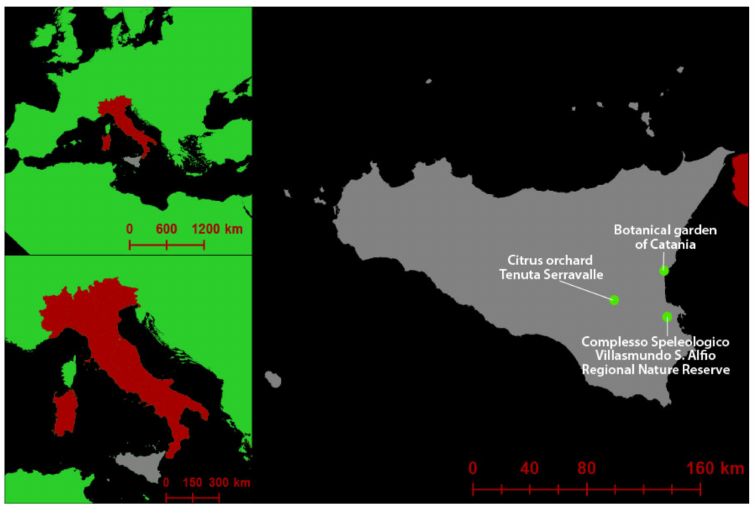
Figure 1. Geographical location of the three surveyed areas included in this study.